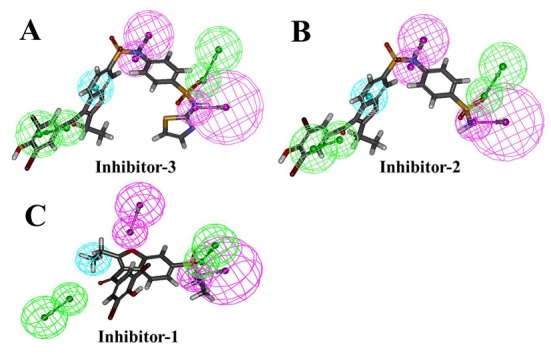
Hypo-1 mapping with the Inhbitior-3 (A) and Inhbiitor-2 (B), matching all the features. Inhibitor-1 (C) showing unmatched H-bond acceptor feature.